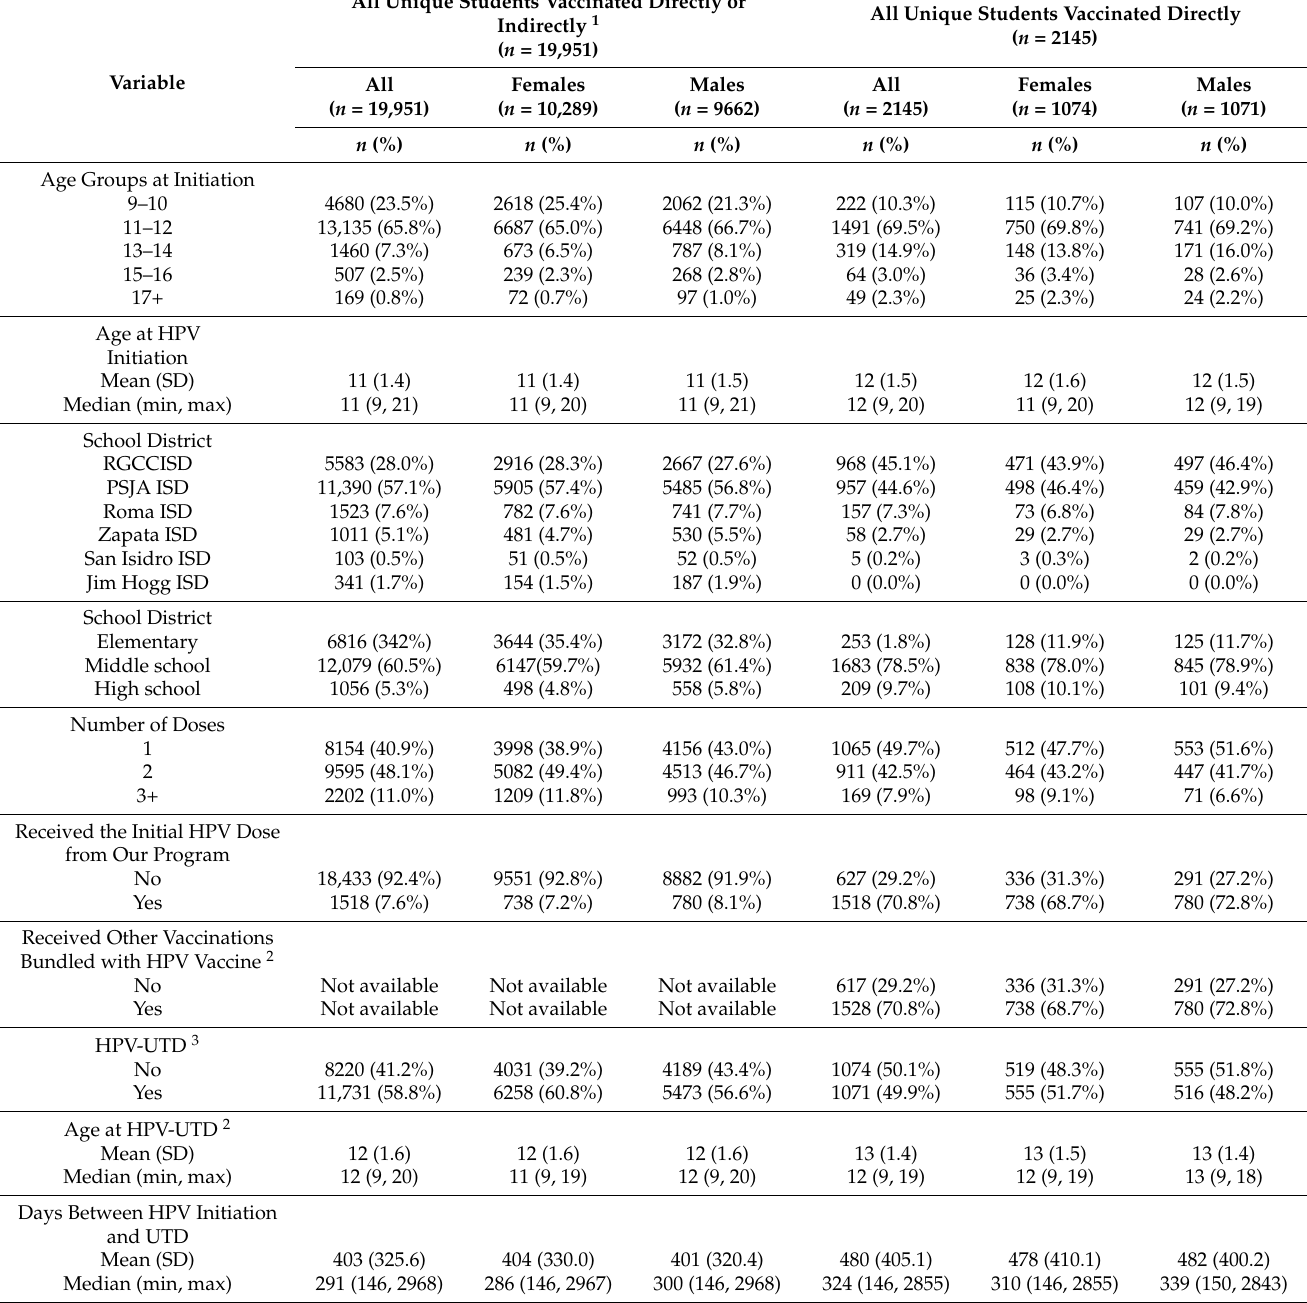
Table 2. Summary of demographic characteristics of the study population by gender were vaccinated directly or indirectly through our program ( n =